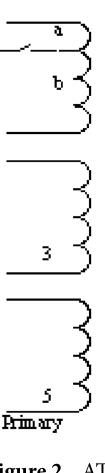
Figure 2. ATP/EMTP model of power transformer with winding-to-ground fault 33